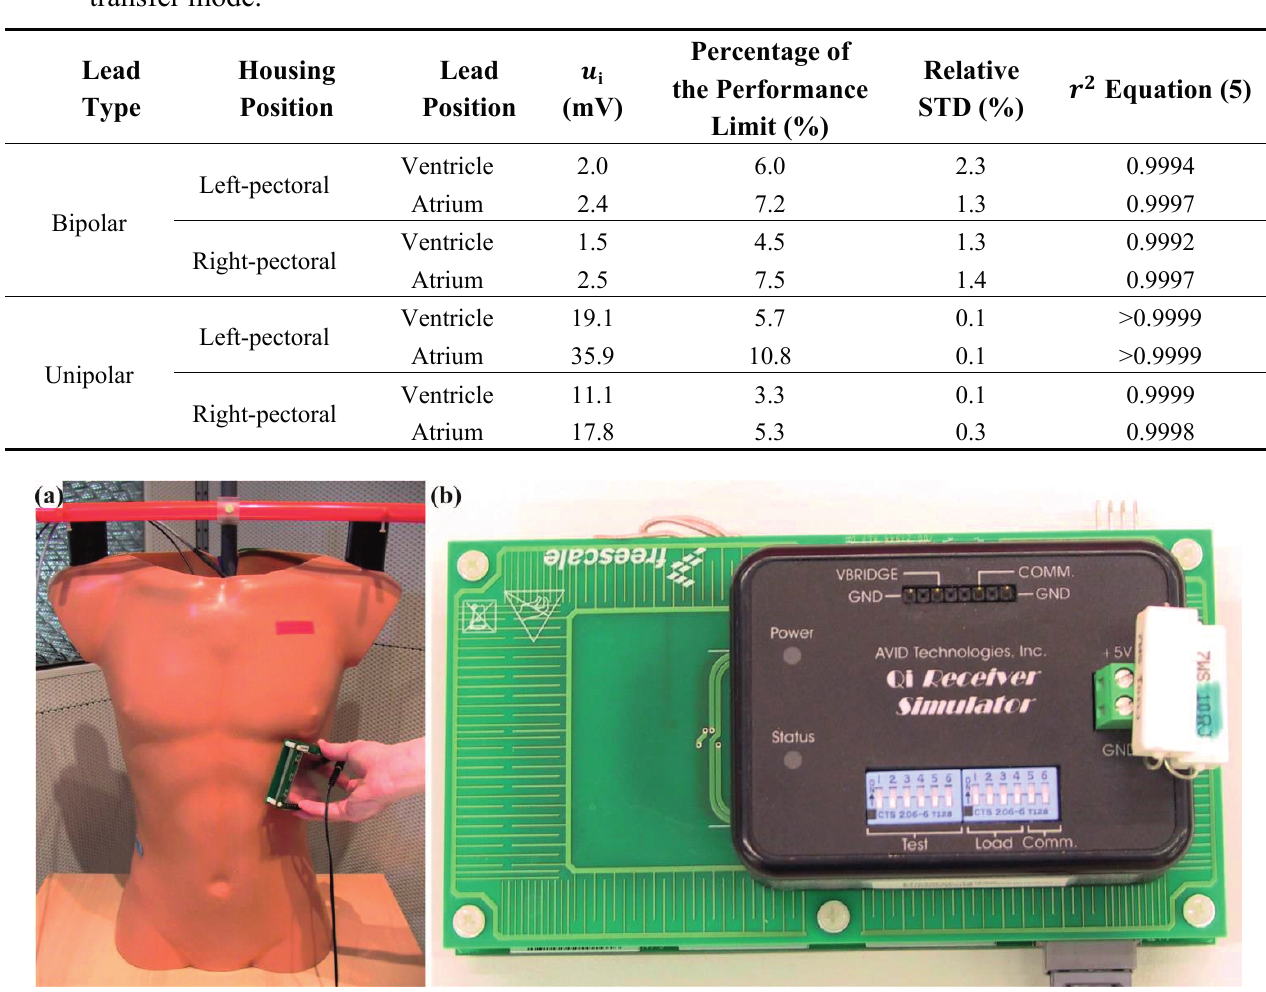
Figure 5. ( a ) Torso phantom and Qi-A13-Board (pinging mode) on the lateral